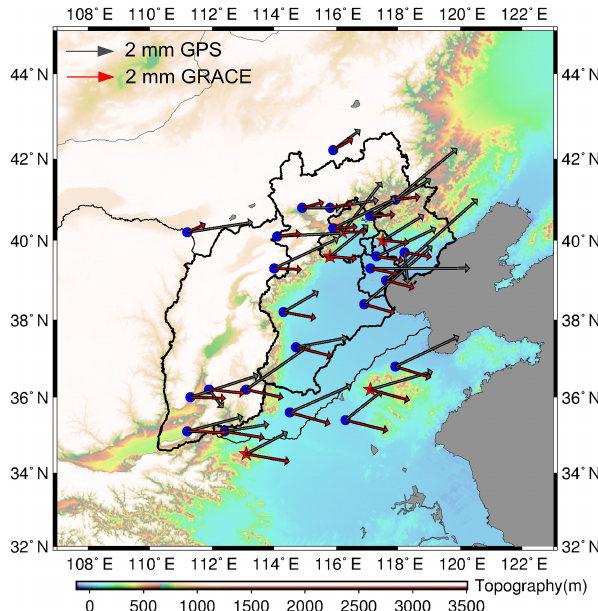
Figure 6. Comparison of annual amplitudes and initial phases be- tween GPS (grey) and GRACE (red). The initial phases are anti- clockwise from the east (reference time is